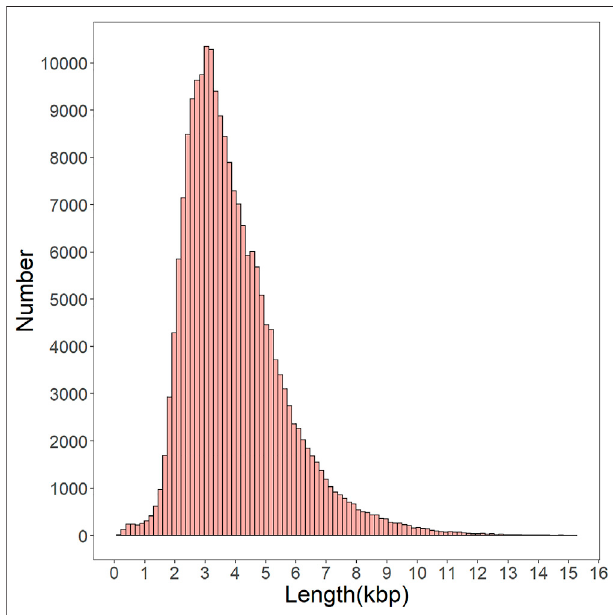
FIGURE 2 | Distribution of nonredundant full-length transcript from the gonad transcriptome of H. schlegelii .